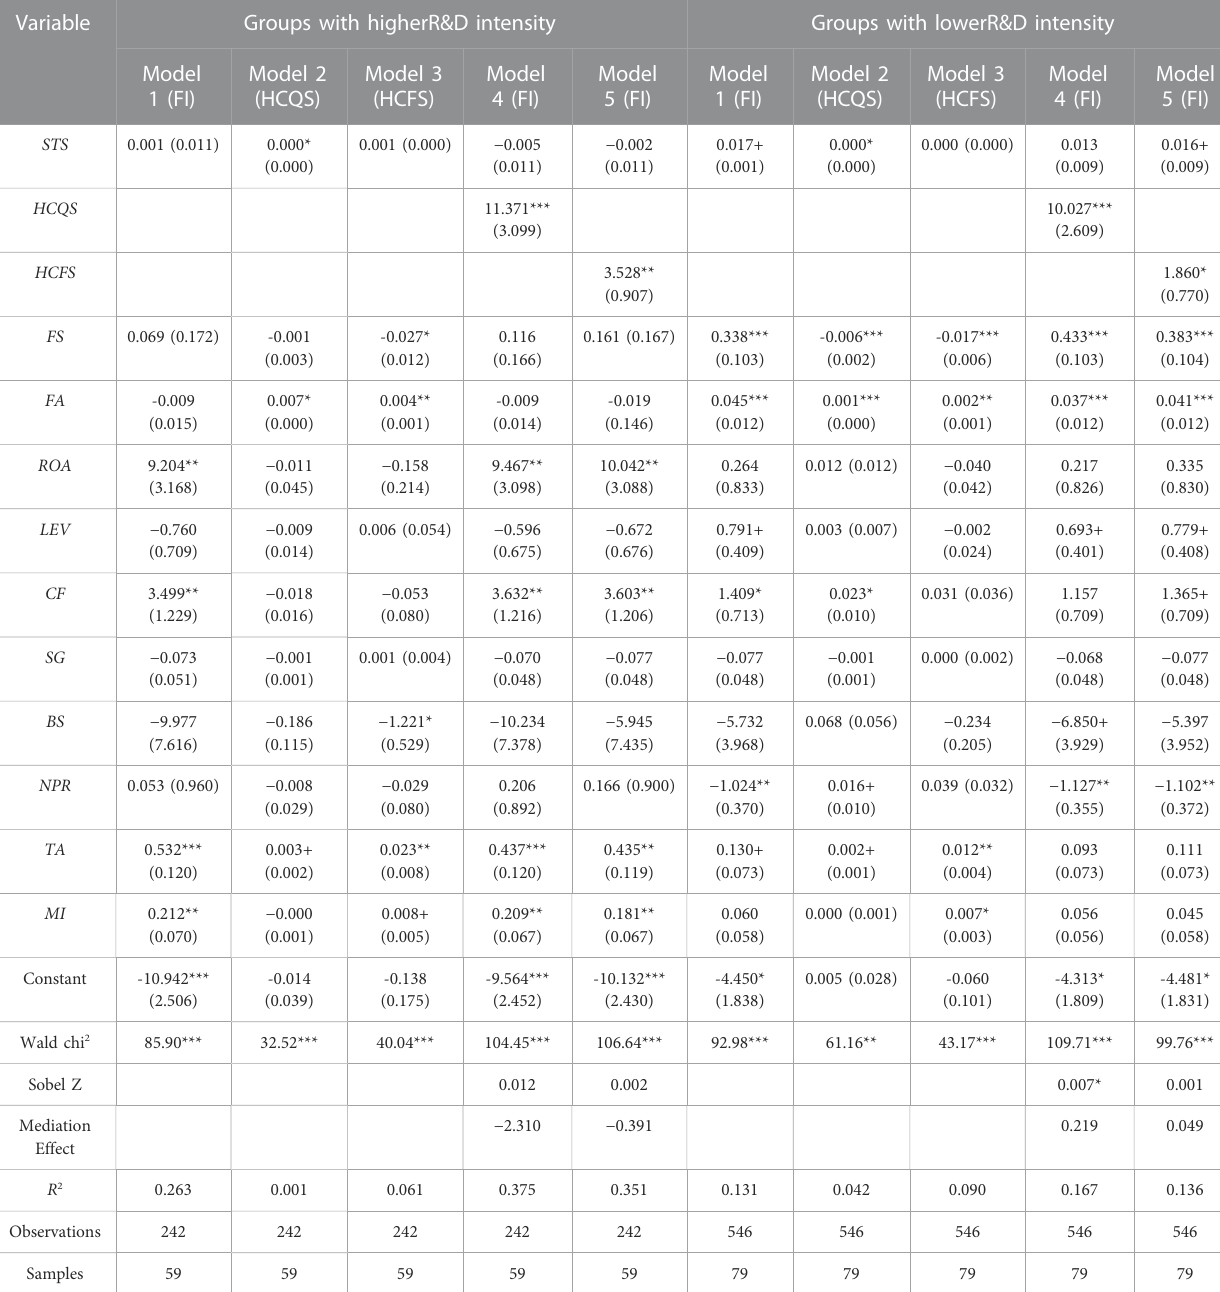
TABLE 15 Regression analysis of higher and lower R&D intensity groups based on the additional control